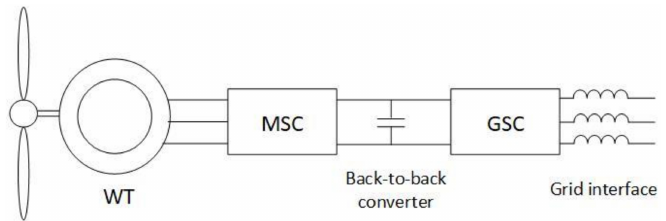
Figure 7. Schematic of grid-connected wind turbine (WT) system.